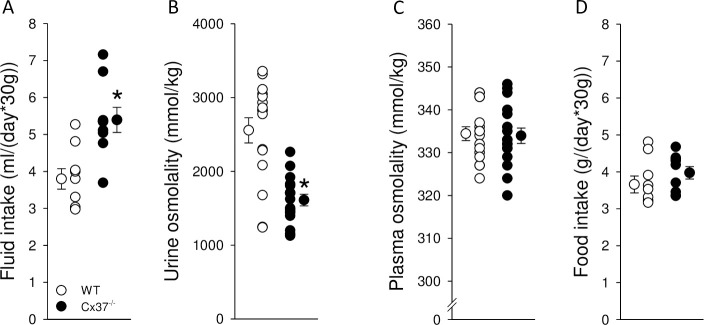
Increased fluid intake and lower urine osmolality in Cx37-/- mice with free access to food and water.(A) Cx37-/- mice have greater fluid intake associated with (B) lower urinary osmolality than WT mice (~142% and ~63% of WT, respectively). Intact water balance is indicated by similar (C) plasma osmolality and (D) food intake between genotypes. Data are expressed as mean ± SEM; n = 9 for fluid and food intake, n = 12–17 for urine and plasma osmolalities. Data were analyzed by Student’s t-test, *P<0.05 versus WT.